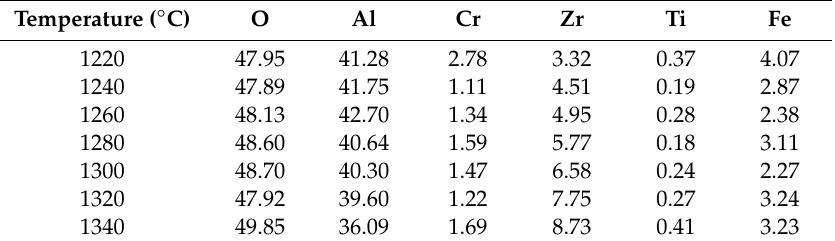
Table 2. Contents of major elements on surfaces of Fe-Cr-Al-Ti-Zr steel oxidized at different temperatures (wt %).